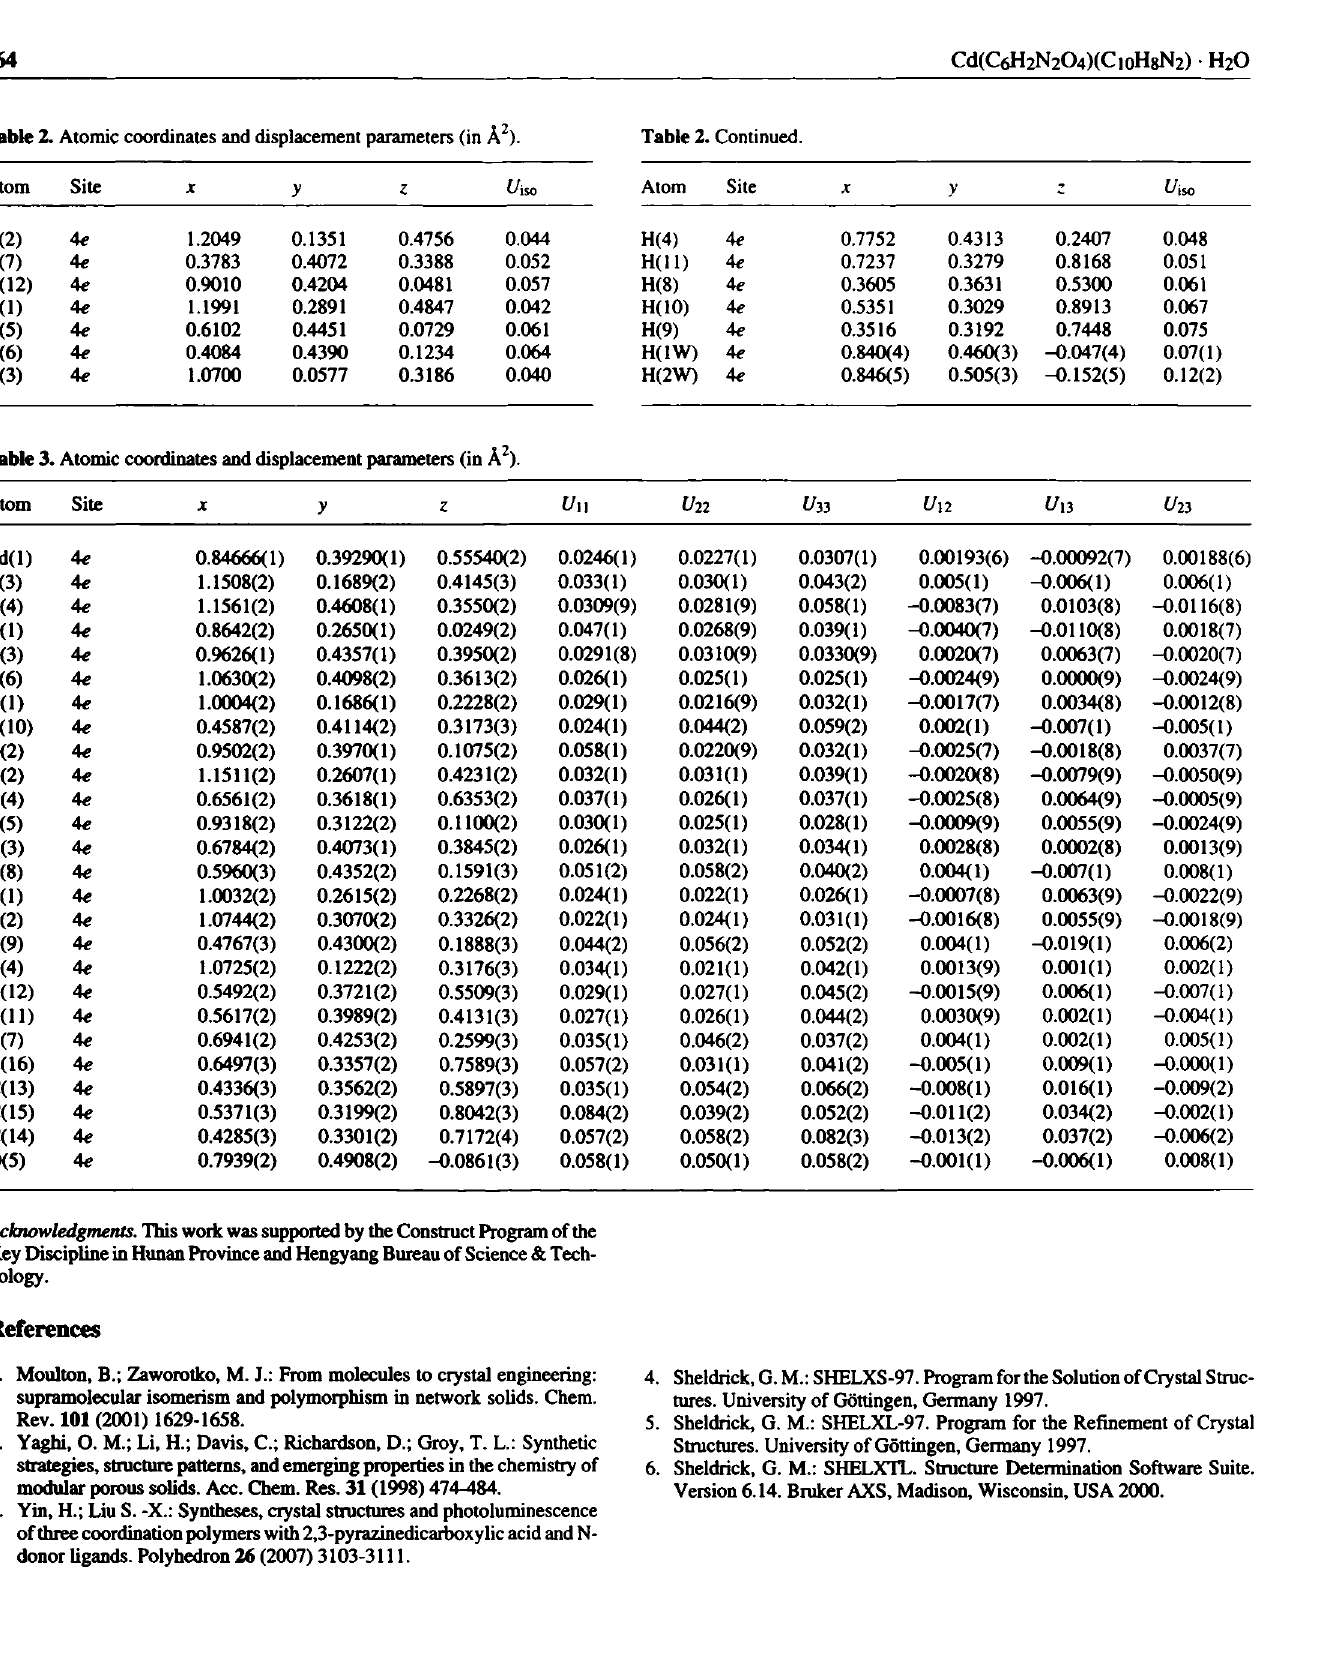
Table 2. Atomic coordinates and displacement parameters (in À 2 ).